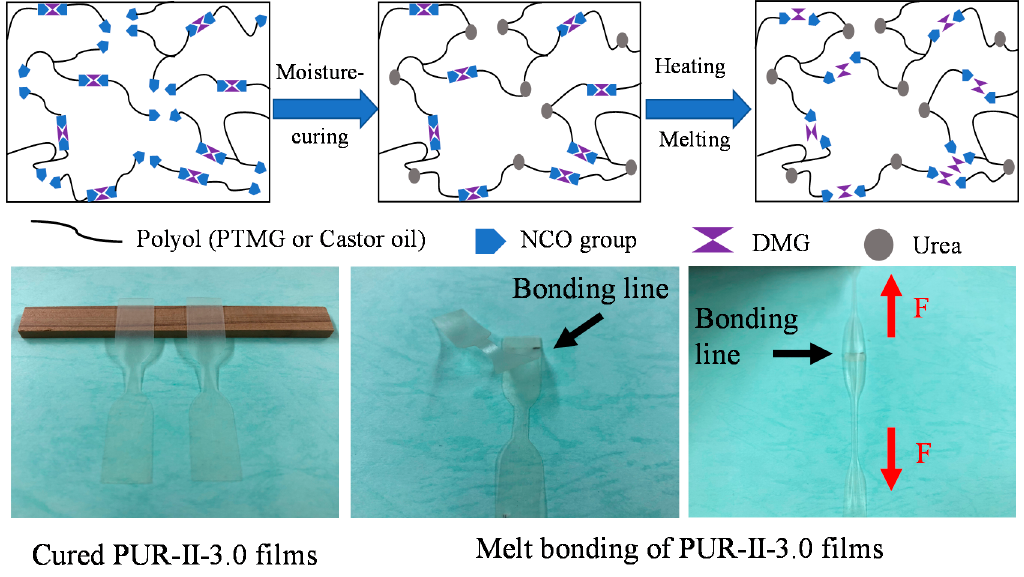
Figure 2. Curing, remeltable reaction and remeltable bonding of PUR containing castor oil and DMG.